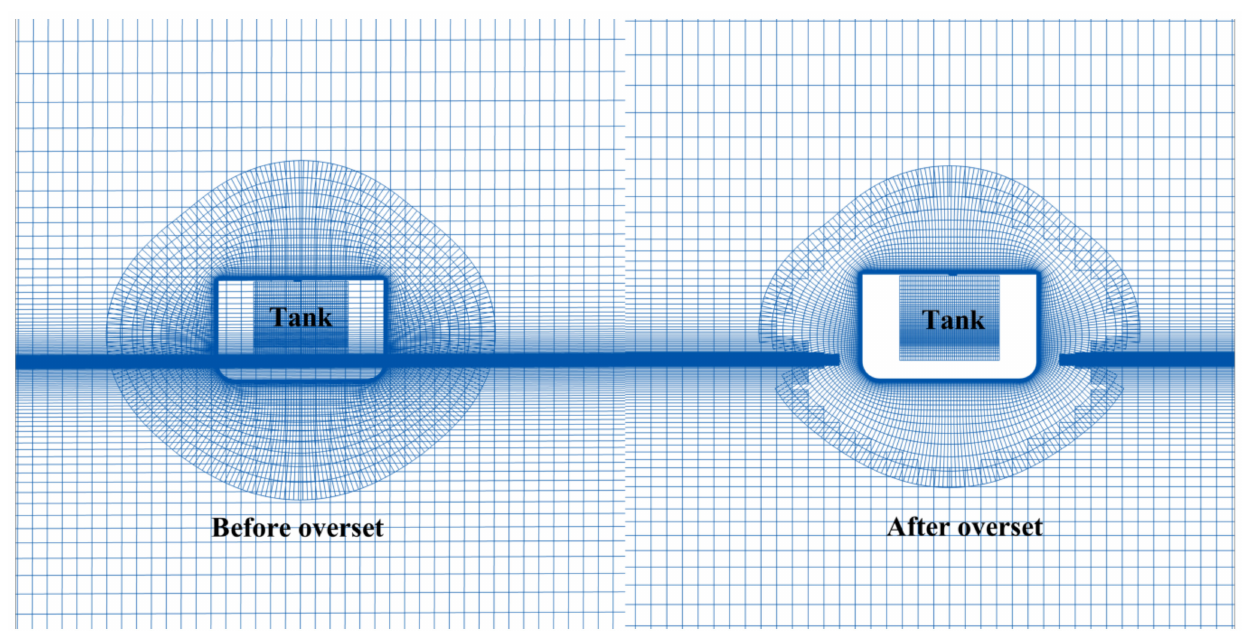
Figure 7. Comparison of the grid before and after